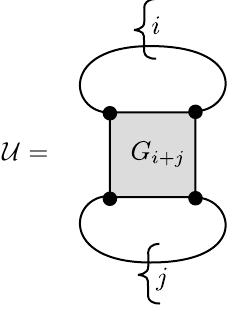
Figure 10. Effective density-functional for the interaction of species i and j given by a density-dependent coupling G i + j as the local limit of a Φ